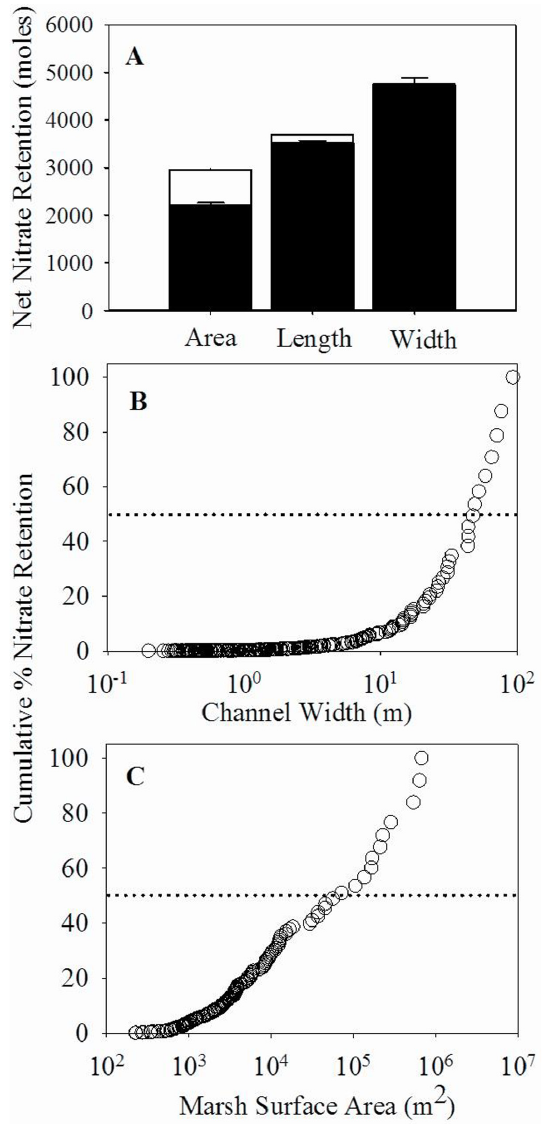
Fig. 8. Total ecosystem nitrate retention calculated from each of the three geomorphic variables. (A) Nitrate retention estimated from marsh surface area data is 1738 . 9 ± 44 . 6mol NO 3 -N, from chan- nel length is 2790 . 1 ± 31 . 2mol NO 3 -N, and from channel width is 3961 . 16 ± 135 . 8mol NO 3 -N. Stacked white bars indicate addi- tional retention calculated by adding in the missing geomorphic data, which were predicted from geomorphic relationships to in- let width. (B) Spatial distribution of nitrate retention as a function of channel width; the 8 largest channels are responsible for 50% of total retention. (C) Spatial distribution of nitrate retention as a func- tion of marsh surface area; the 11 largest marshes are responsible for 50% of total